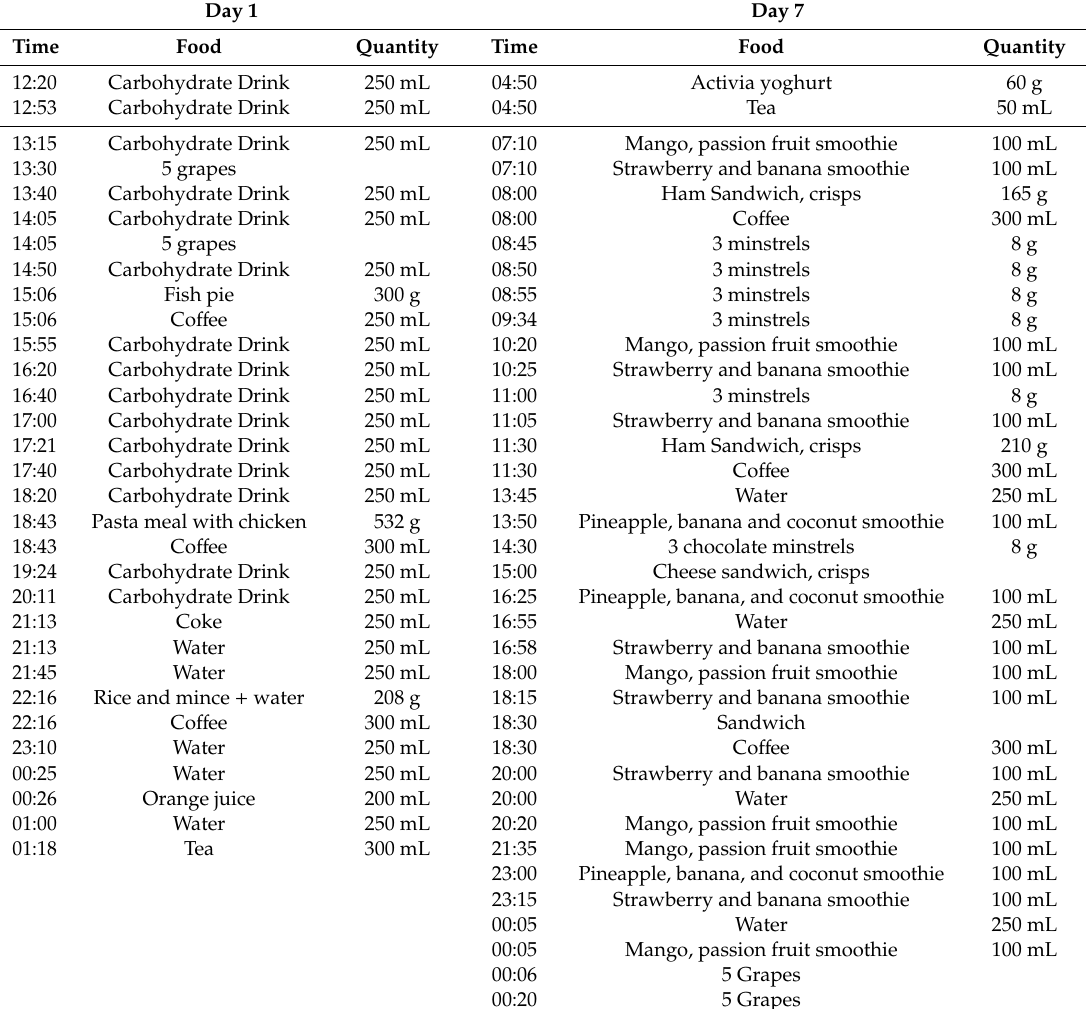
Table 1. Example of food and fluid intake for days 1 and 7 during the world record